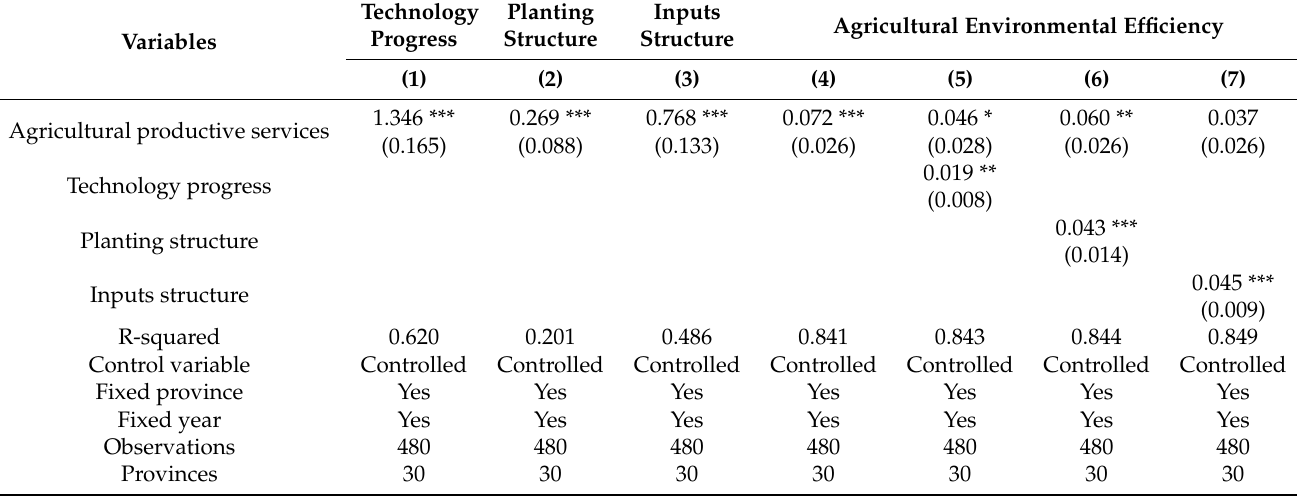
Table 5. Results of the causal steps approach for mediating effect